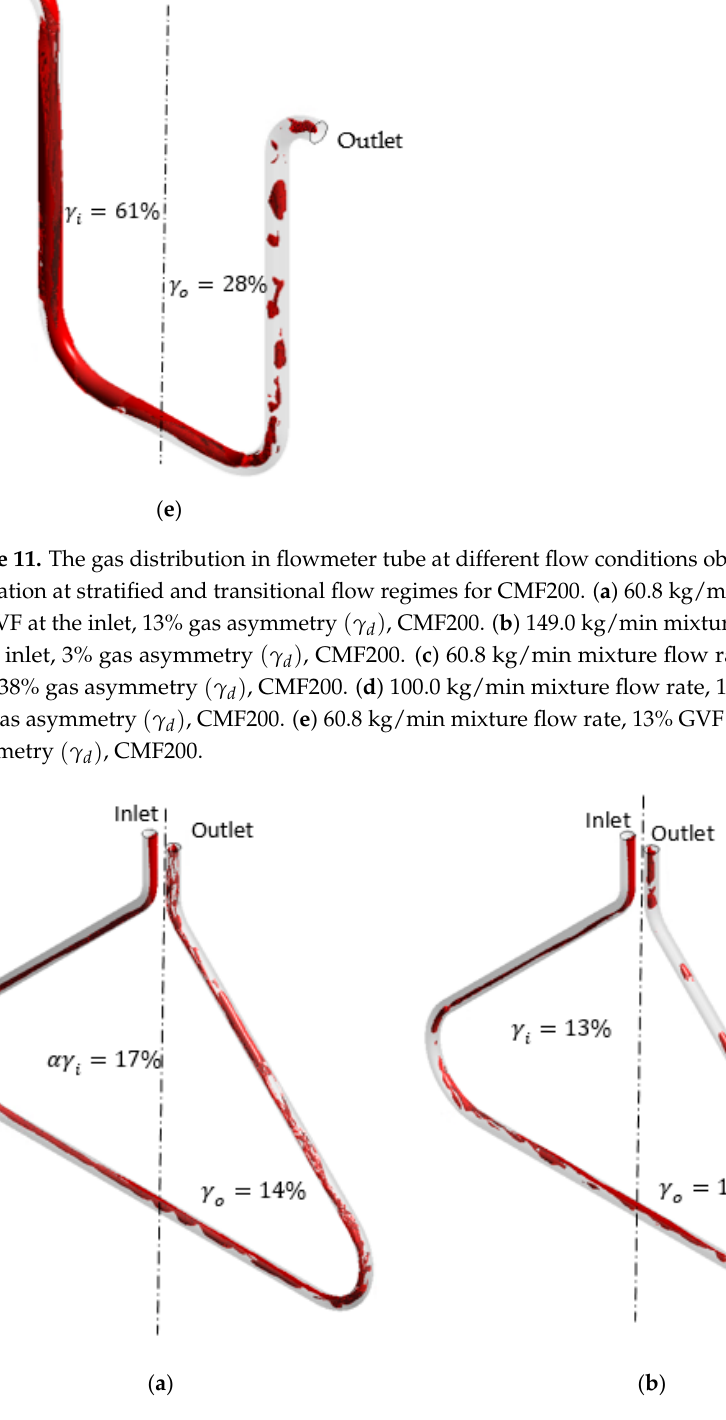
Figure 12. The gas distribution in flowmeter tube at different flow conditions obtained by numerical simulation at stratified and transitional flow regimes for CMF050. ( a ) 40.0 kg/min mixture flow rate, 15% GVF at the inlet, 3% gas asymmetry ( γ d ) , CMF050. ( b ) 40.0 kg/min mixture flow rate, 10% GVF at the inlet, 2% gas asymmetry ( γ d ) ,